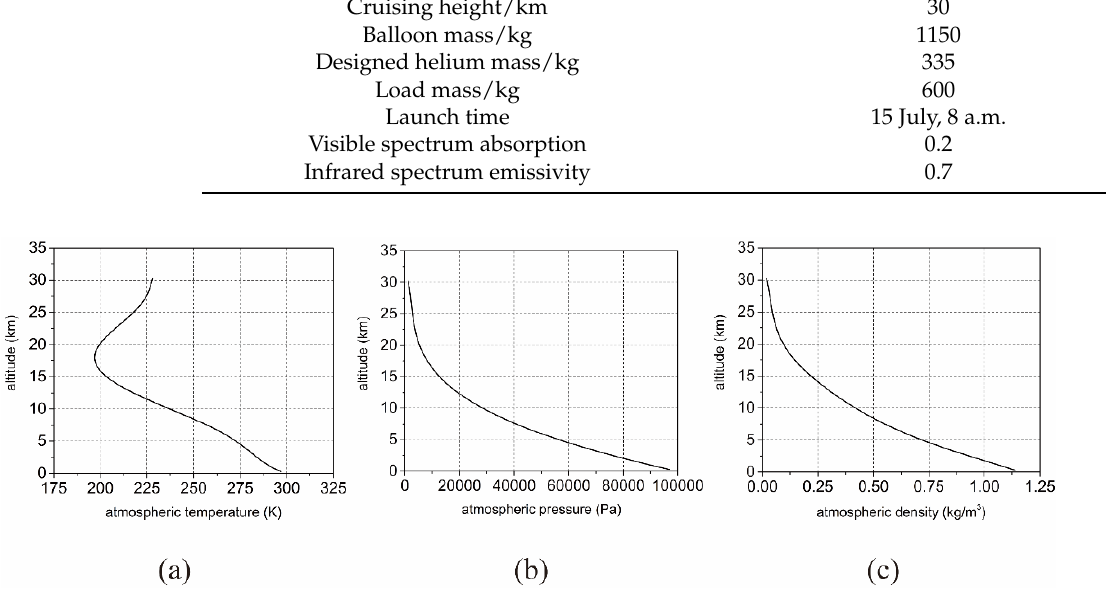
Figure 7. The ( a ) temperature, ( b ) pressure and ( c ) density of